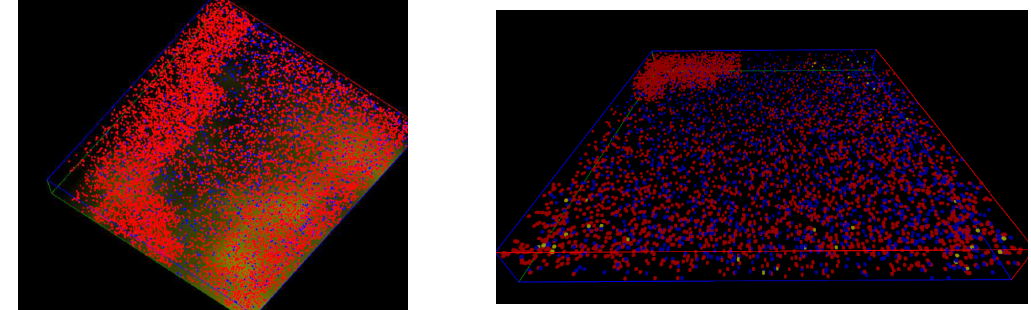
Figure 3: Redi’s screenshots of output’s visualization.